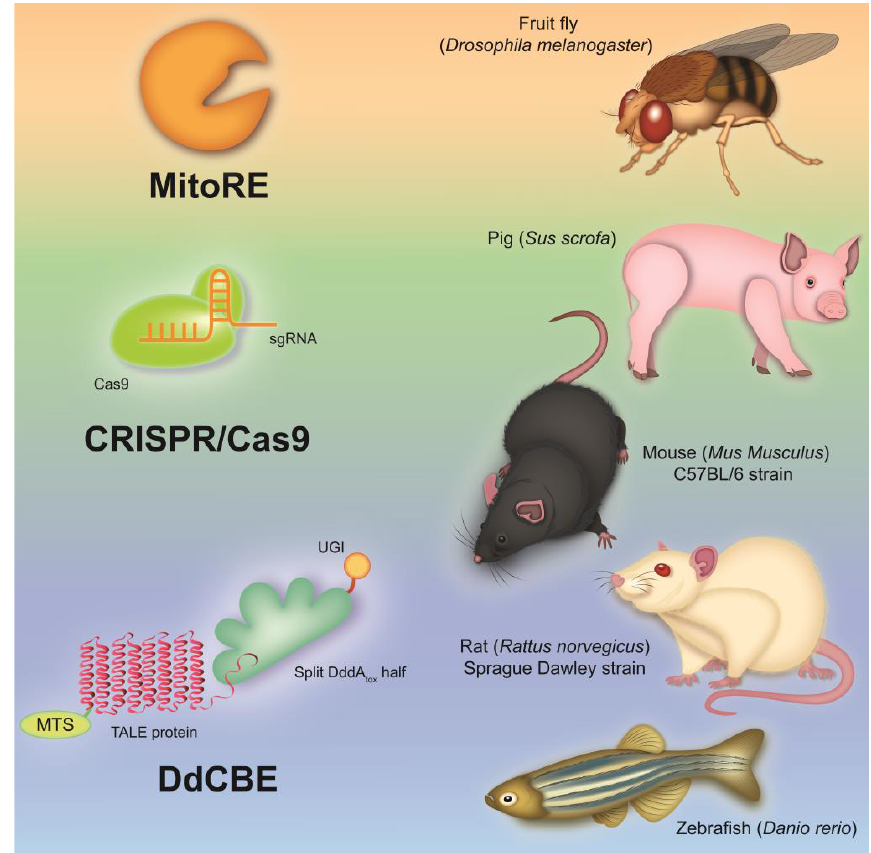
Figure 1. Animal models of mitochondrial disease created through genome editing techniques. There are a number of animal models of mitochondrial diseases caused by defects in nuclear and mtDNA. Thus, to study defects in nuclear-encoded mitochondrial proteins, knockout mice and pigs were created using CRISPR/Cas9. Despite many limitations in their application, models of invertebrate animals, such as the fruit fly, created using mitochondria-targeted restriction endonucleases, are quite common. Nevertheless, the most promising models of mitochondrial diseases at the moment are mice, rats and zebrafish, with mutations in mtDNA introduced by DdCBEs.